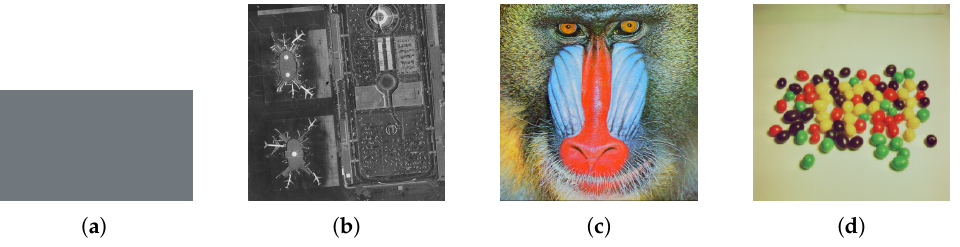
Figure 2. Adopted base images: ( a ) solid colour; ( b ) airport; ( c ) baboon; ( d )